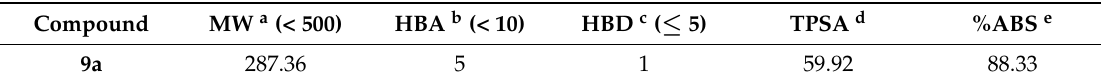
Table 5. Pharmacokinetic parameters of compound 9a